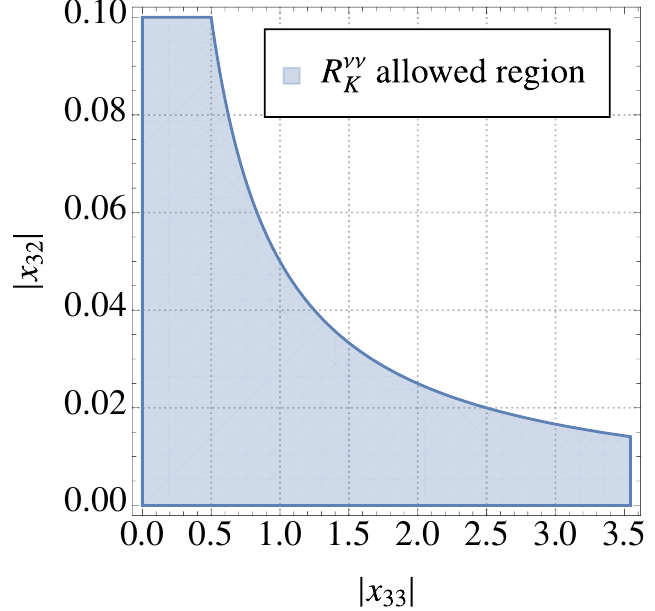
Figure 8. The region allowed by experimental limits on the decay B ! K(cid:23)(cid:23) in the j x 33 j { j x 32 j plane for m = 1 TeV. All other couplings are switched o(cid:11). A large value of j x 33 j is essential (cid:30)